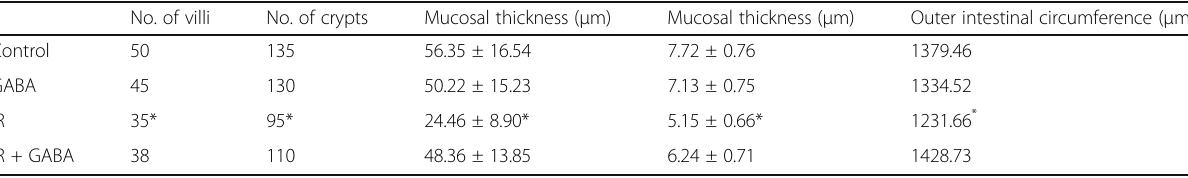
Table 1 Morphometric parameters in the studied groups No. of villi